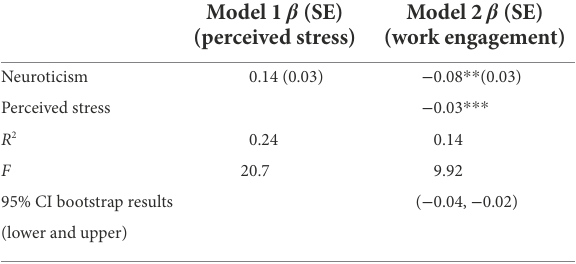
TABLE 3 Mediation effect of perceived stress on neuroticism-work engagement relationship.